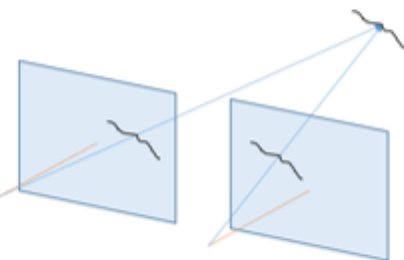
Figure 8. Forward intersection of stereo pair images